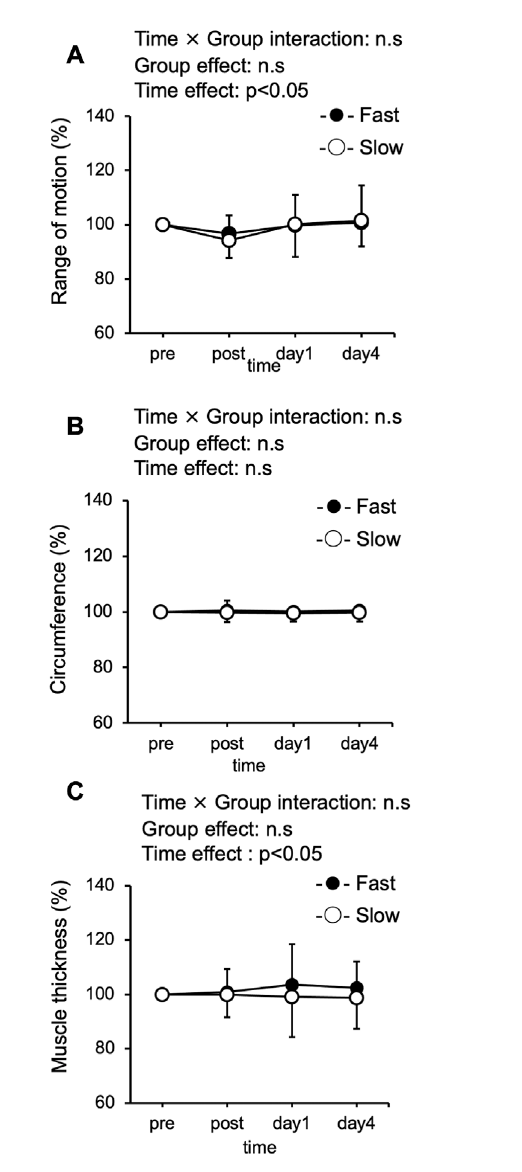
FIGURE 3 Changes (mean ± SD) in range of motion (A) , thigh circumference (B) , and muscle thickness (C) , immediately after (post), 1 day, and 4 days after exercise in the fast velocity session (Fast) and slow velocity session